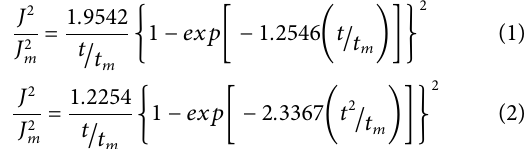
Frontiers in Chemistry |